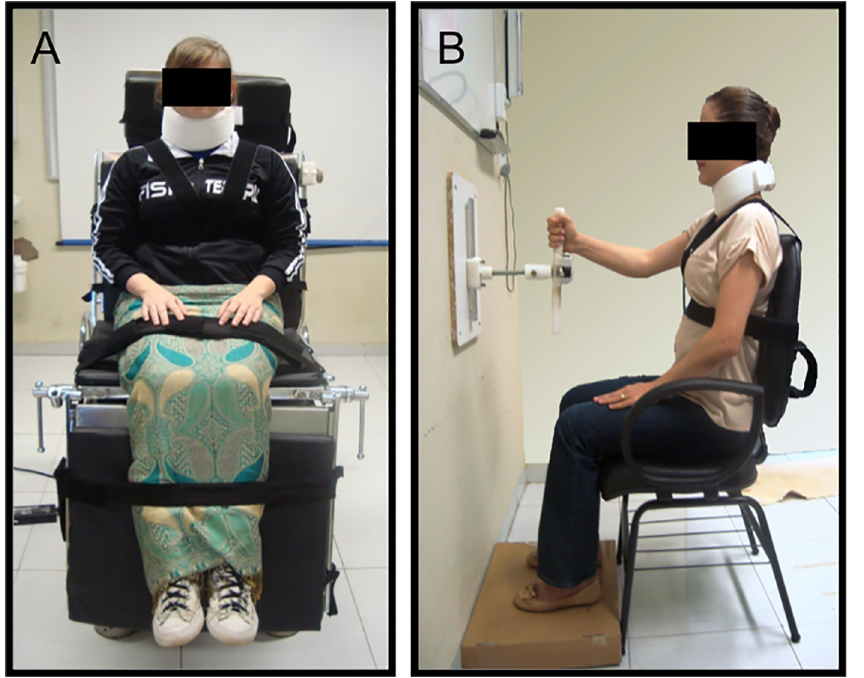
Fig 1. Position of the patient during SPV and HV tests. (A) SPV test. (B) HV